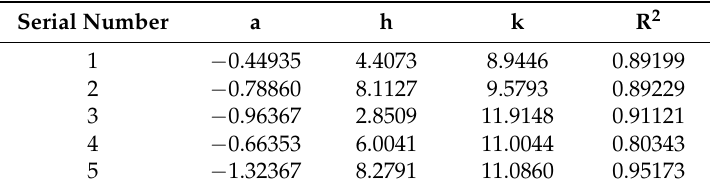
Table 1. Fitted parabolic equation parameters.